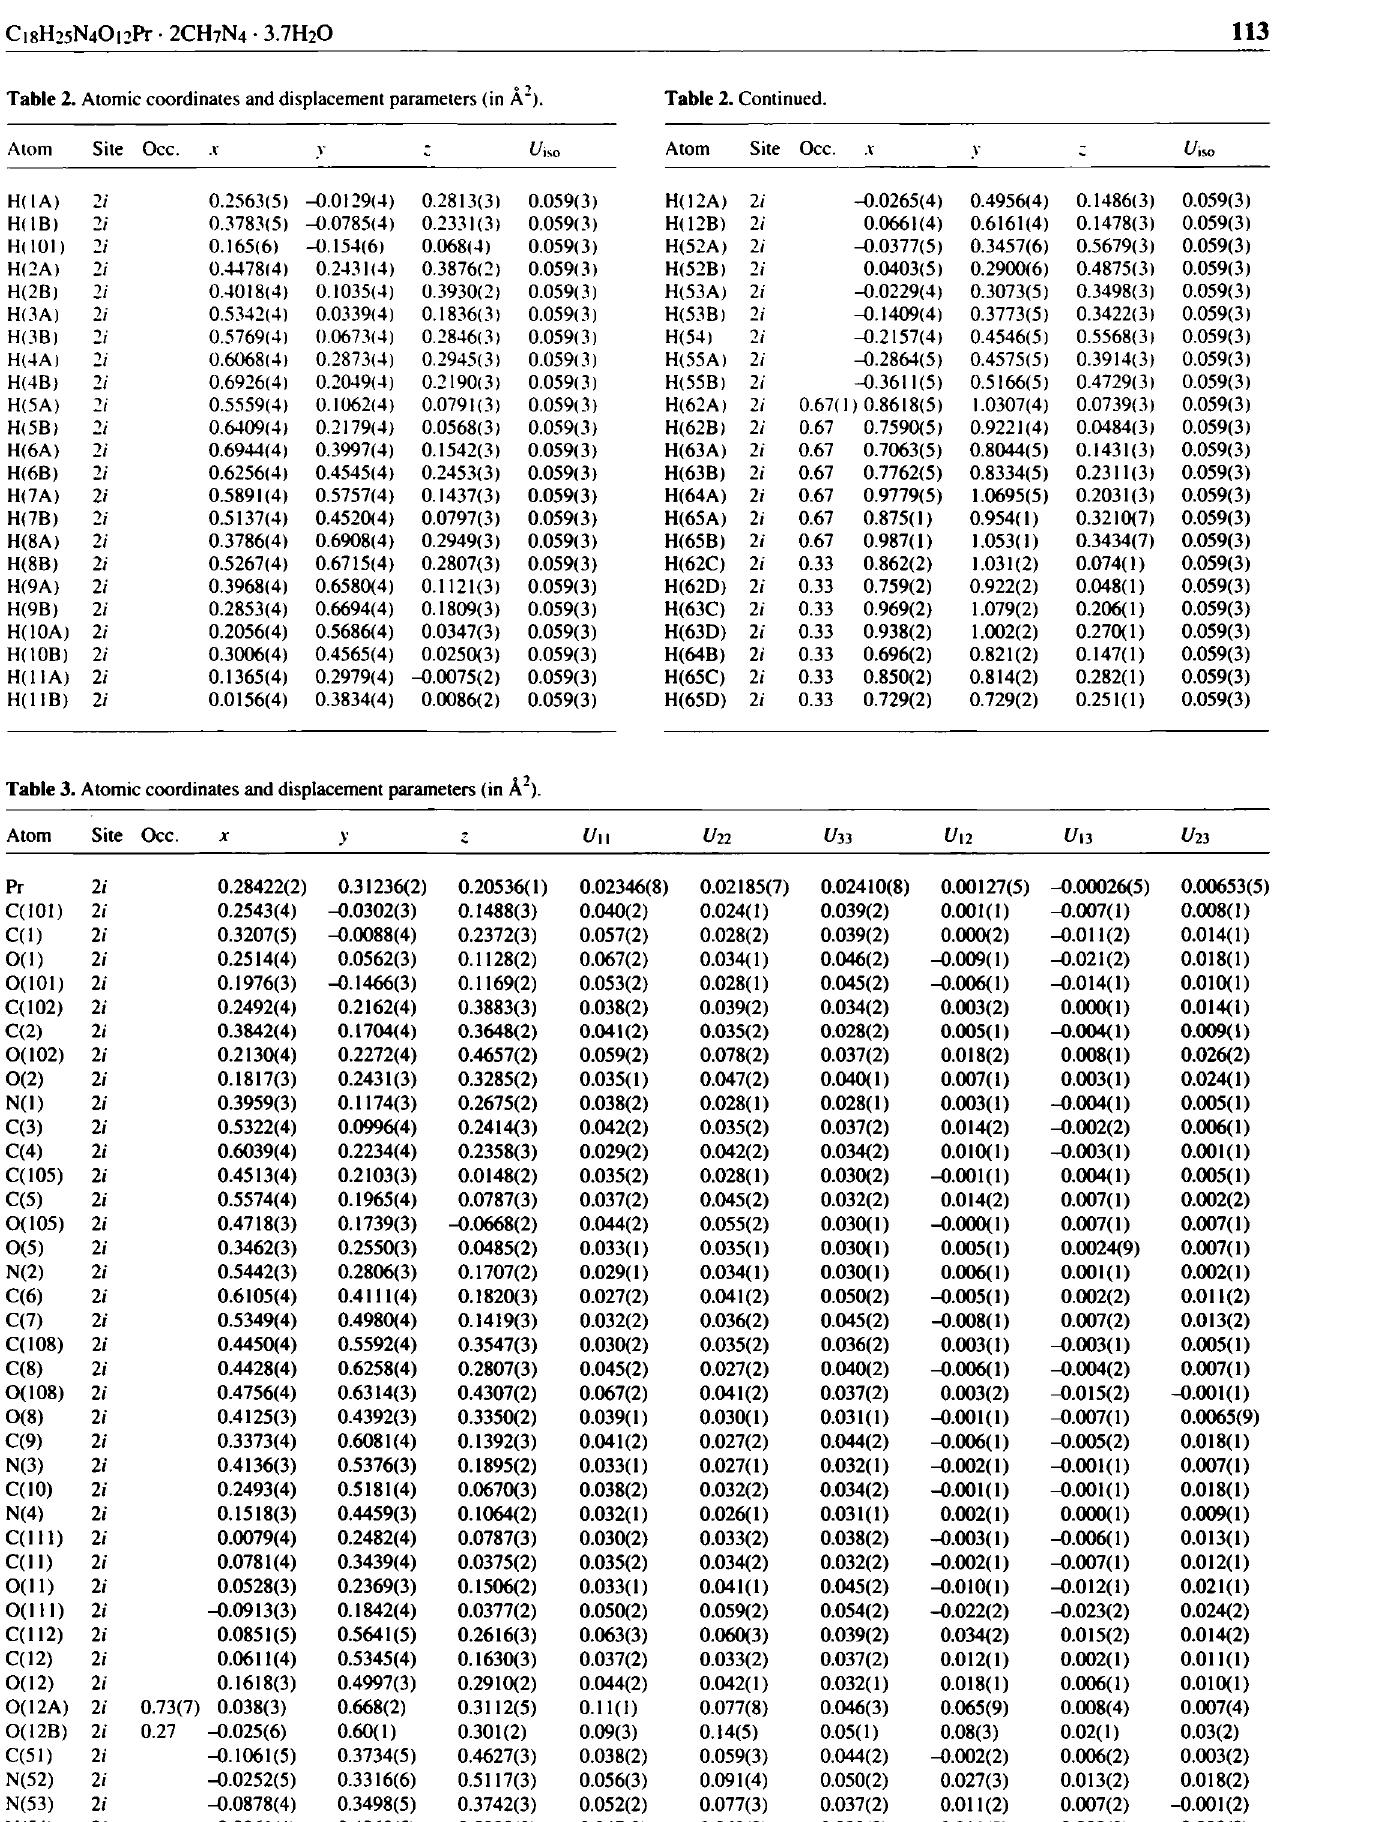
Table 2. Atomic coordinates and displacement parameters (in A"). Table 2. Continued.